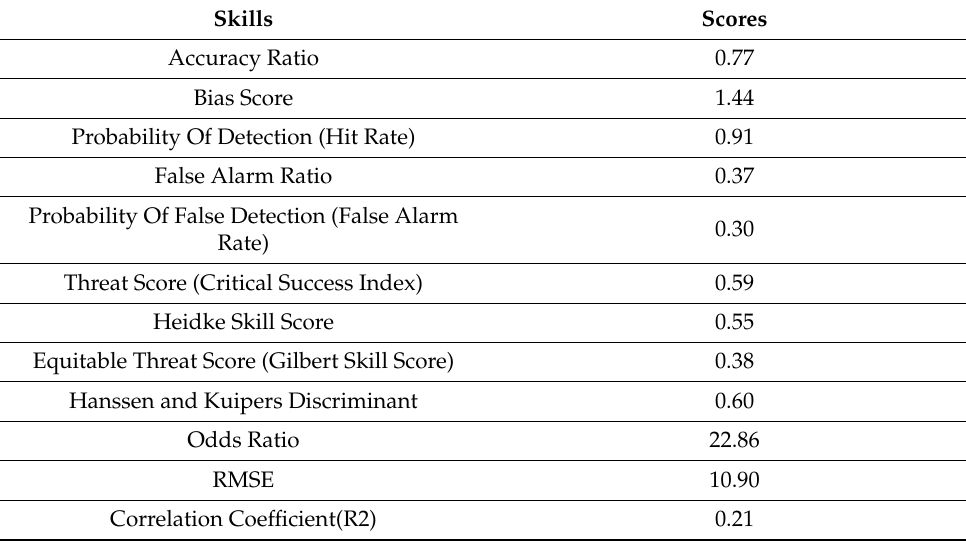
Table 2. Skill score for rainfall for maize-growing season, 2021–2022.